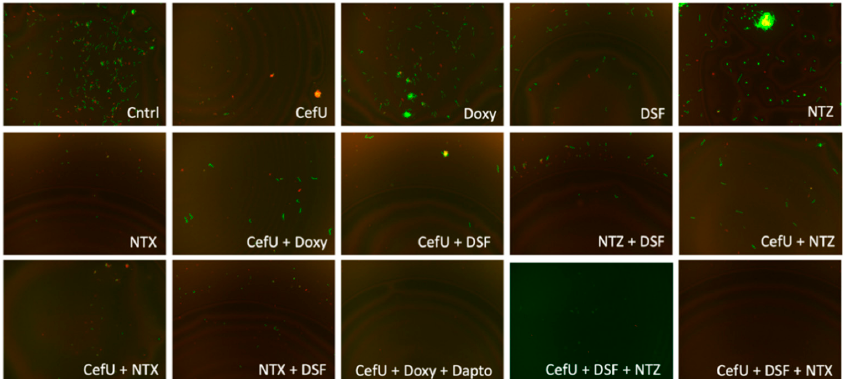
Each “+” (regrowth) or “–“ (no regrowth) symbol represents one replicate. Abbreviations: untreated control (Cntrl), cefuroxime (CefU), clarithromycin (Clari), daptomycin (Dapto), disulfiram (DSF), doxycycline (Doxy), furazolidone (FZD), nitazoxanide (NTZ), nitroxoline (NTX).